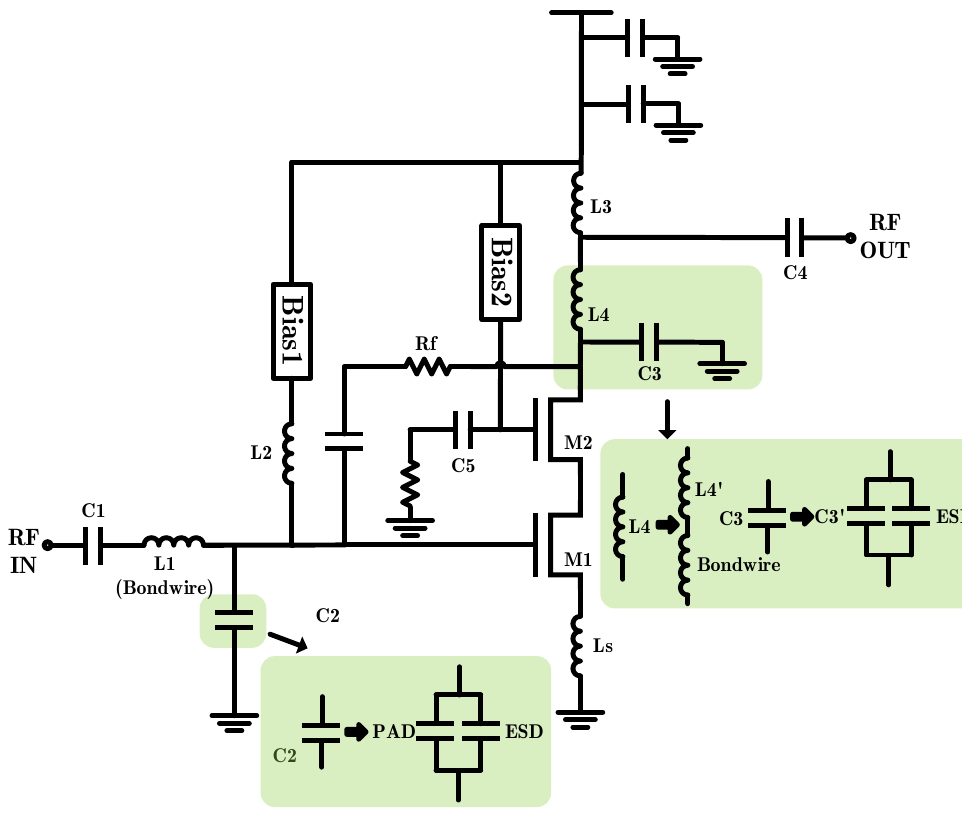
Figure 6. The complete circuit of the proposed LNA.